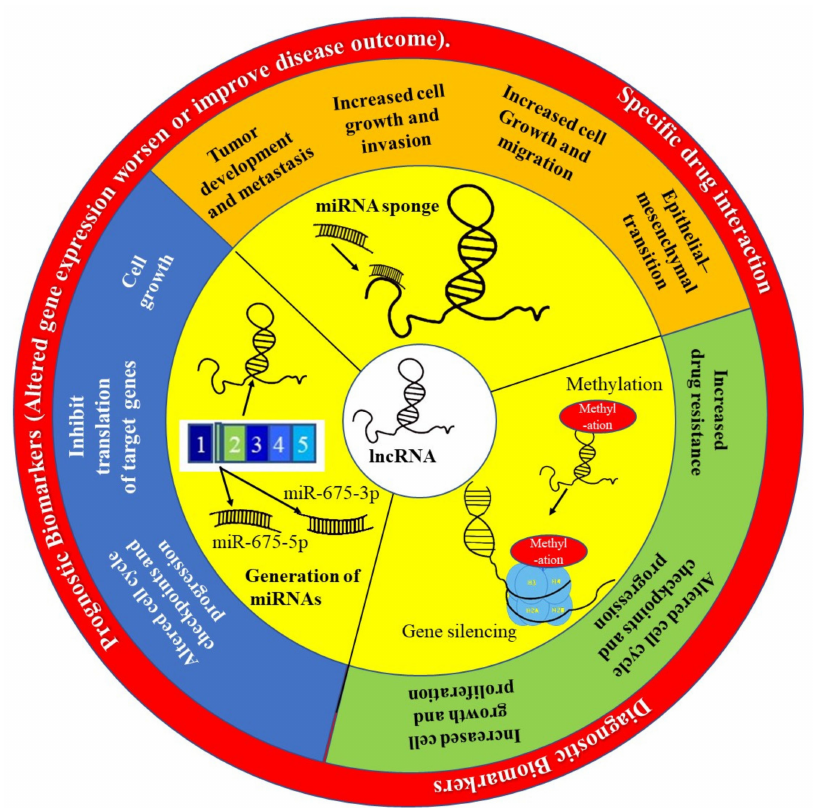
Figure 5. The role of lncRNA in precision oncology. The lncRNA H19 has been implicated as